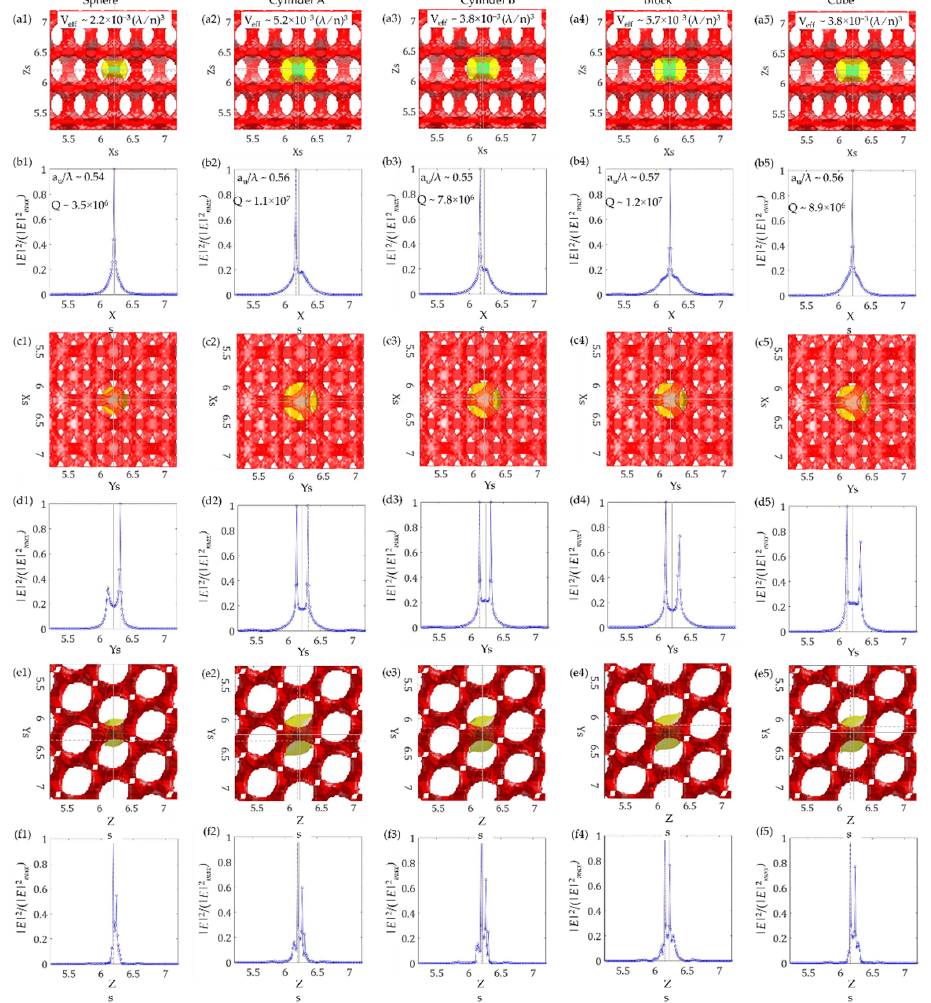
Figure 7. Isosurfaces of the material (red), and of the normalized square of the electric field distributions for |E| 2 /|E| 2 max = 0.03 (yellow) with embedded low-index ( n def = 1.0) truncated regions of various defect shapes (in the case of r d = 0.1 a u ): a sphere ( a1 – f1 ), cylinder A ( a2 – f2 ), cylinder B ( a3 – f3 ), a block ( a4 – f4 ) and a cube ( a5 – f5 ). The cavities were excited by a dipole with an electric field oriented along the Z s directions, using a short Gaussian pulse. The solid lines show the center of the defect and the dashed lines show the position of the maximum electric-field value. ( b1 – b5 , d1 – d5 , f1 – f5 ): one-dimensional cross-section plots of the normalized square of the electric field ( |E| 2 /|E| 2 max ) created along the X s , Y s , and Z s axes, and going through the maxima of each field distribution (dashed lines on the 3D isosurface plots).